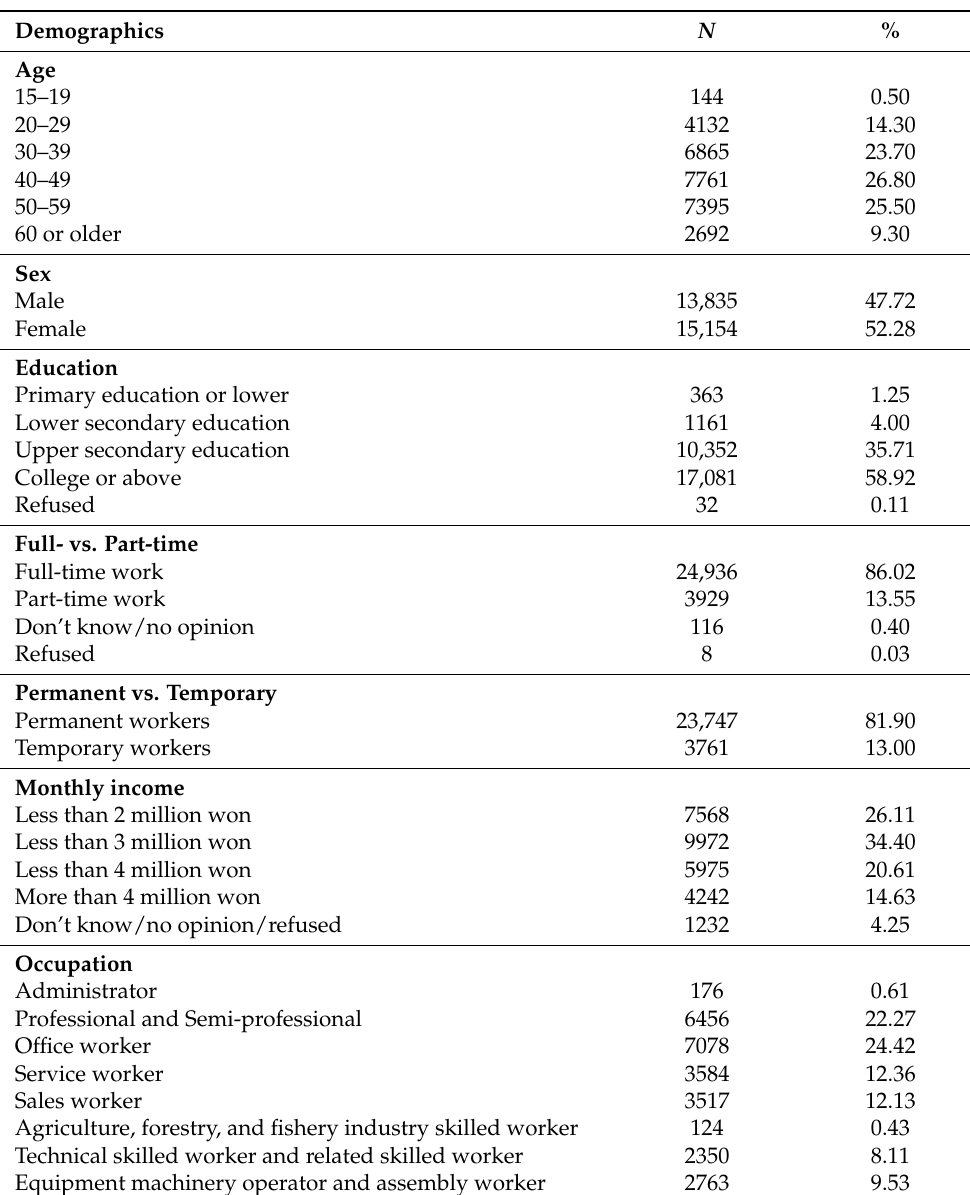
Table 1. Sociodemographic information of the